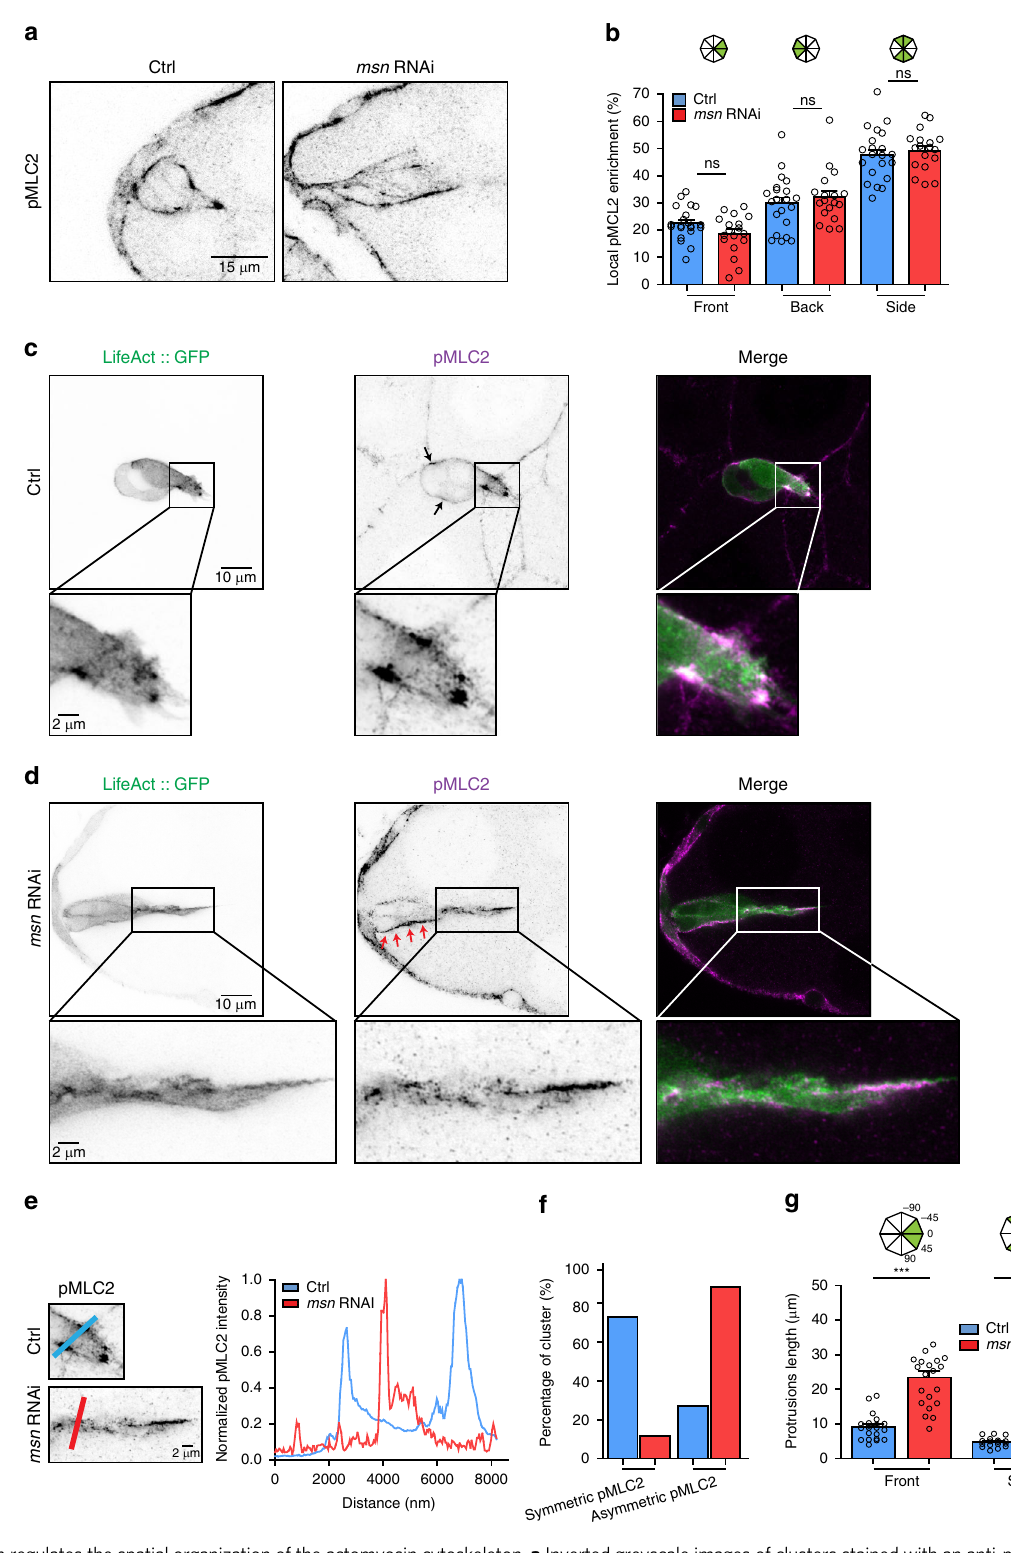
Fig. 5 Msn regulates the spatial organization of the actomyosin cytoskeleton. a Inverted greyscale images of clusters stained with an anti-phosphorylated (Ser19) Myosin II Light Chain (pMLC2) antibody in control and Msn-depleted clusters. b Local pMLC2 enrichment is represented as the percentage of the signal at the front, back or side of the cluster over the signal of the entire cluster ( n = 21 independent Control BC clusters and n = 18 independent msn RNAi BC clusters). c and d Representative images of control c and Msn - depleted clusters d expressing LifeAct::GFP and stained for pMLC2. Black arrows point to pMLC2 foci in the control cluster and red arrows to the continuous lateral accumulation of pMLC2 along the Msn-depleted cluster. e Analysis of the pMCL2 distribution in the front protrusion in control and Msn-depleted clusters. f Percentage of clusters with symmetric or asymmetric enrichment of pMLC2 at the protrusion basis ( n = 21 independent Control BC clusters and n = 16 independent msn RNAi BC clusters). g Length of front and side protrusions in control and Msn-depleted clusters ( n = 20 independent BC clusters, for both conditions). Non-signi fi cant (ns) p >0.05, *** p <0.001, unpaired Student ’ s t -test Error bars show